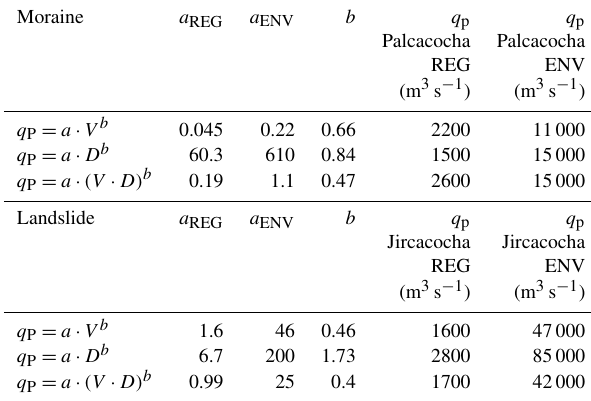
Table 4. Empirical relationships for the peak discharge in case of breach of moraine and landslide dams (Walder and O’Connor, 1997), and the peak discharges estimated for Lake Palcacocha and Lake Jircacocha. q p = peak discharge (m 3 s − 1 ), V = total vol- ume of water passing through the breach (m 3 ); D = drop of lake level (m); REG = regression; ENV = envelope. The values of V and D for the two lakes are summarized in Table 1. See also Ri- vas et al.